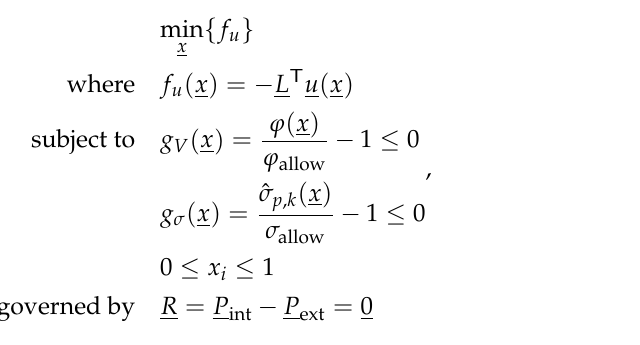
Table 1. Material parameters for a generic polyether ether ketone (PEEK). Parameter Symbol Value Units Young’s modulus E 4232 MPa Poisson’s ratio ν 0.36 Limit stress σ limit